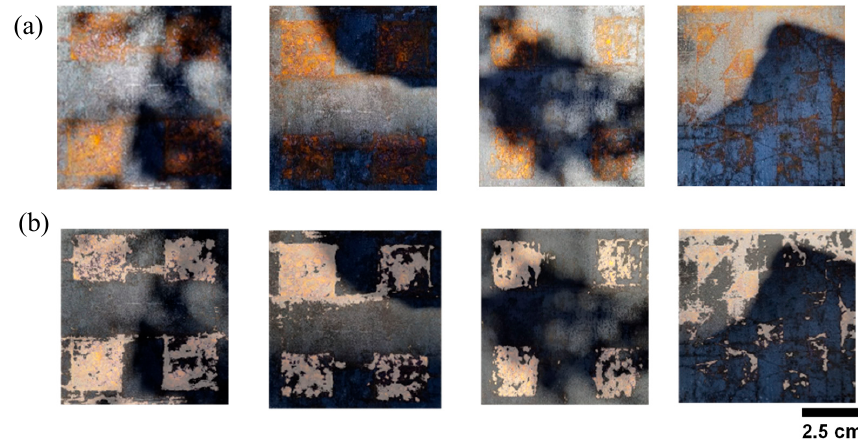
Figure 8. Test images of partially corroded steel plates with shadows cast in natural daylight. ( a ) ground truth images, ( b ) MLP-based corrosion prediction.